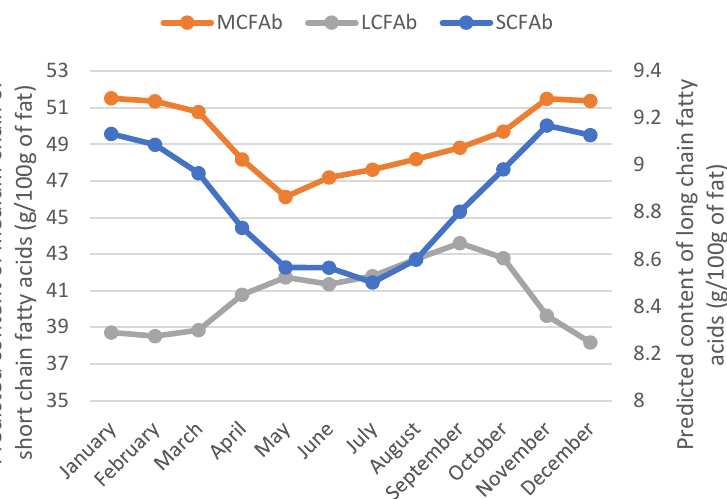
Figure 2. Yearly evolution of the ratio of predicted unsaturated to saturated fatty acids and the pre- dicted content of C18:2 cis-9, trans-11 and C18:3 cis-9, cis-12, cis-15 in milk fat.